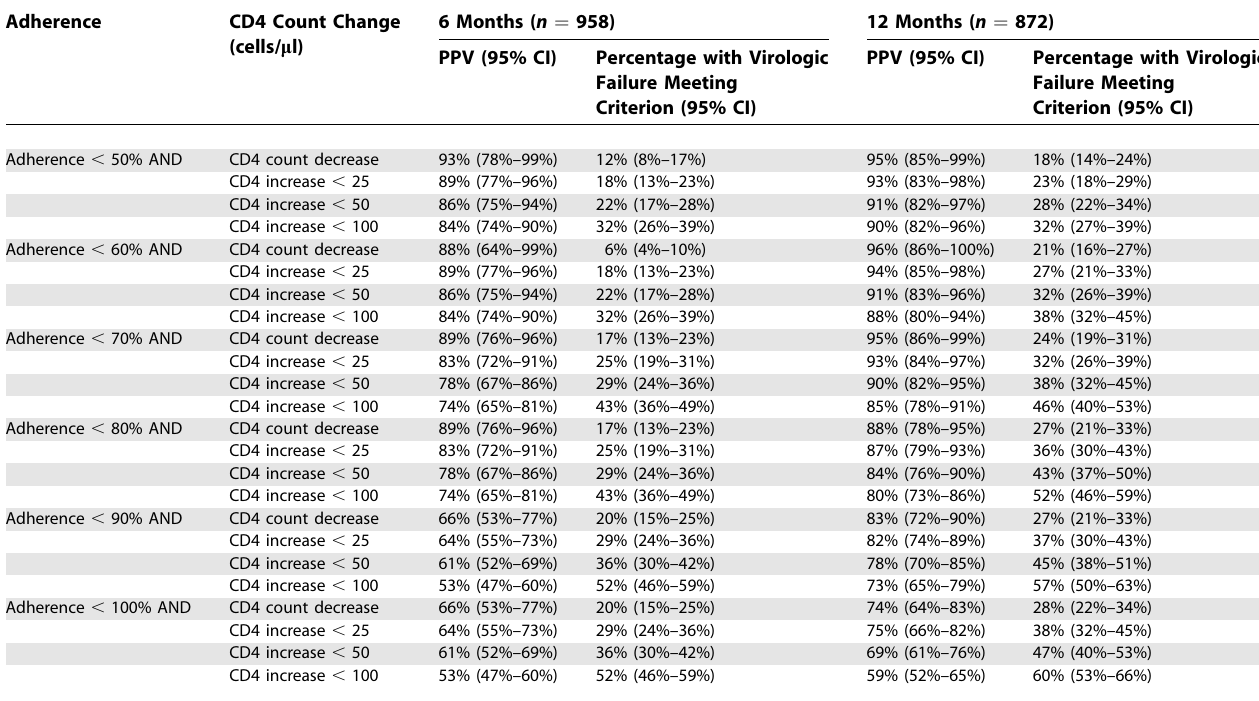
Table 6. PPVs of CD4 Count and Adherence Data Combined for Virologic Failure at 6 and 12 Months Adherence CD4 Count Change (cells/ l